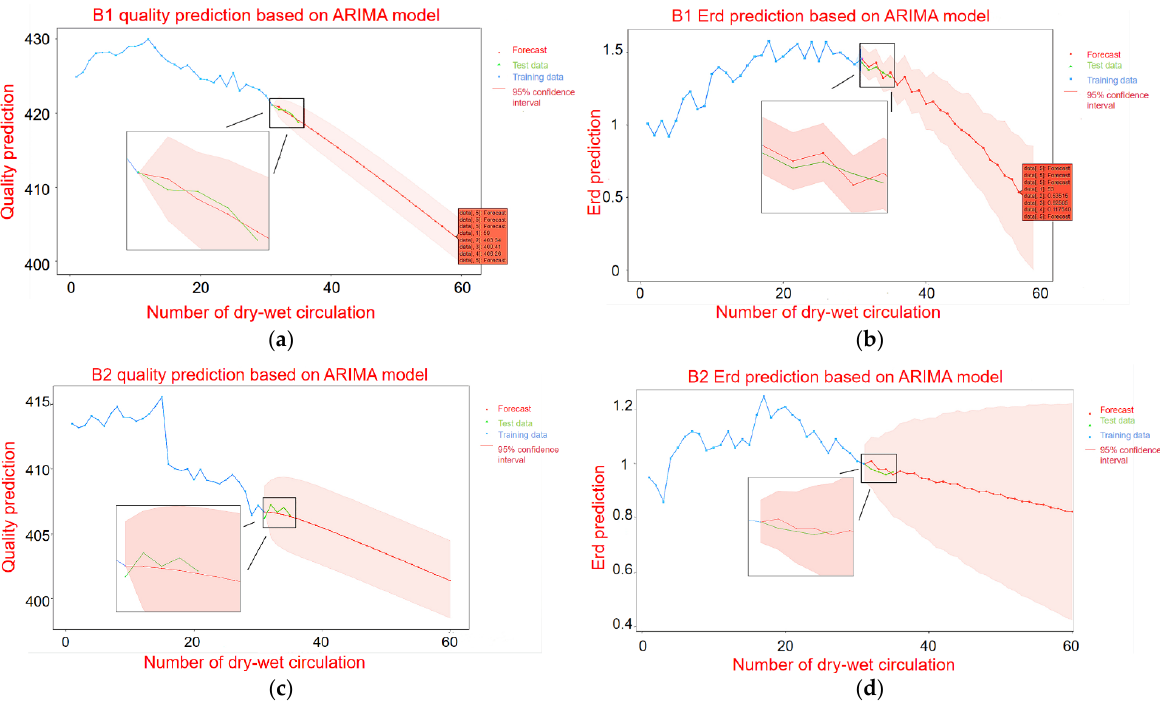
Figure 9. ARIMA time series model prediction of mass and Erd of B1 and B2; ( a ) B1 mass prediction; ( b ) Prediction of B1 Erd; ( c ) B2 mass prediction; ( d ) Prediction of B2 Erd. Table 3. ARIMA time series prediction table ( a ) Predicted value and error analysis of time series B1 ( b ) Predicted value and error analysis of time series